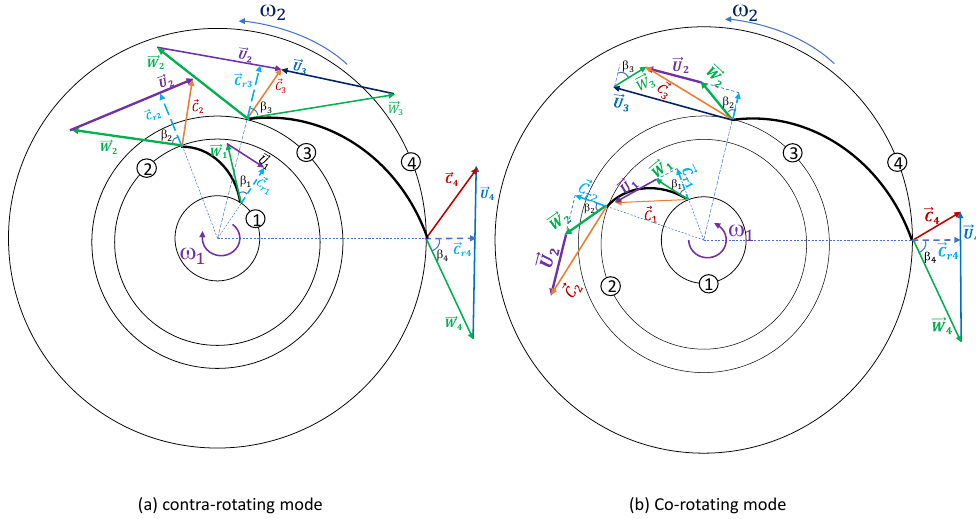
Figure 4. Velocity triangles of TICC in two operating mode: counter-rotating ( a ) and co-rotating ( b ). 1—Upstream-impeller inlet, 2—Upstream-impeller outlet, 3—Downstream-impeller inlet and 4—Downstream-impeller